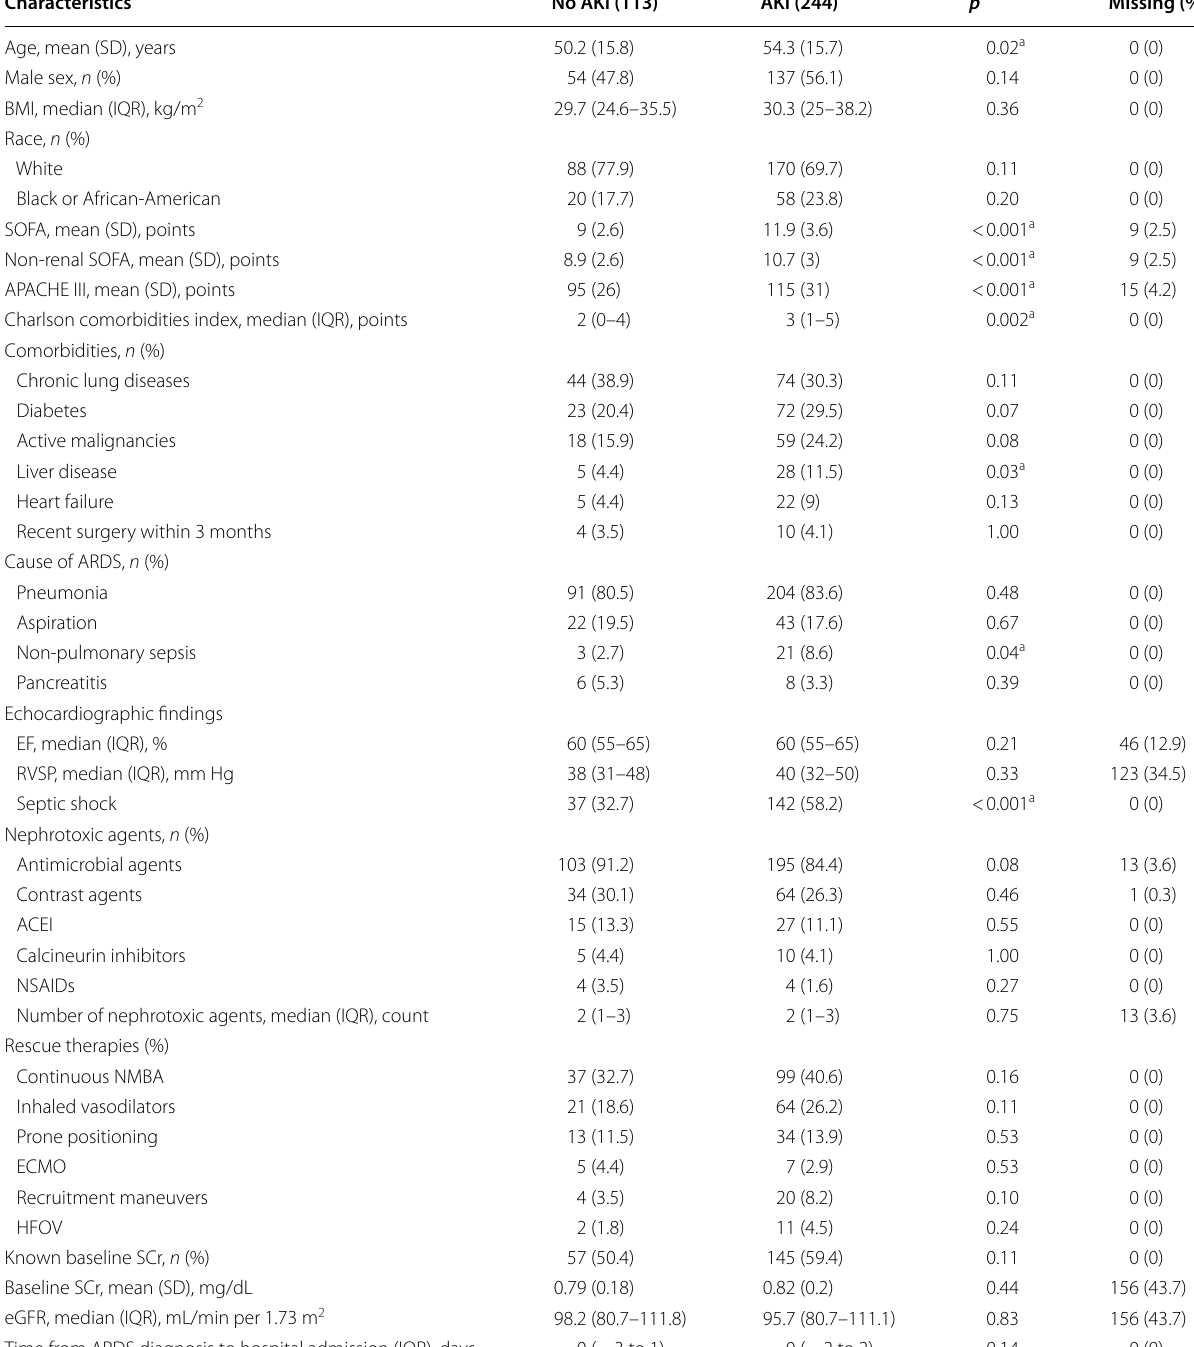
Table 1 Baseline characteristics by acute kidney